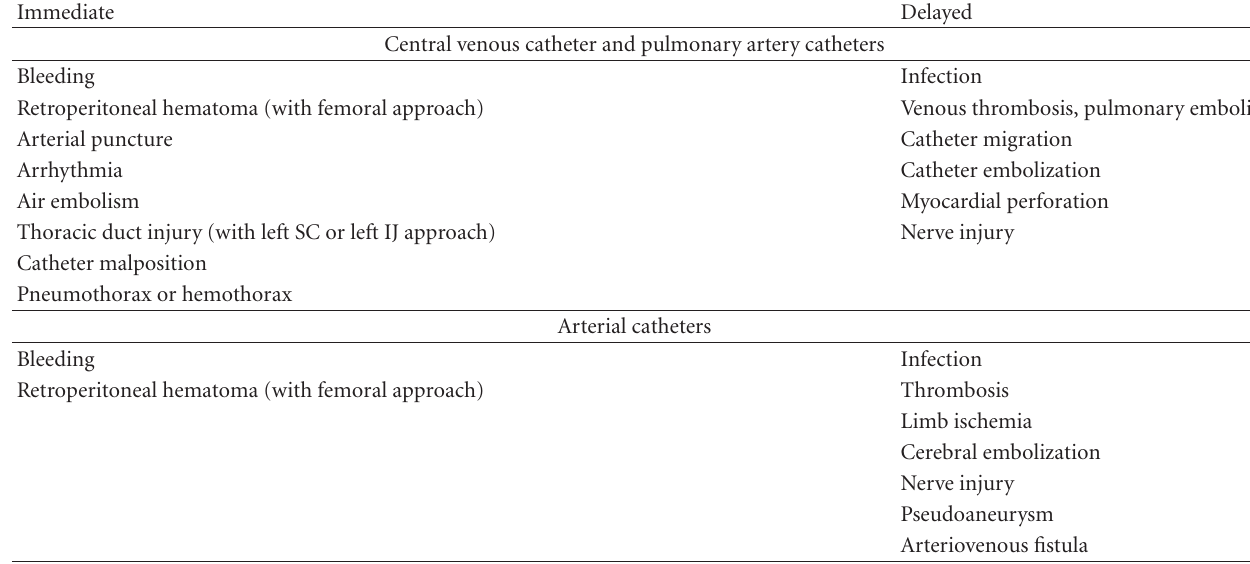
Table 5: Complications of vascular catheters.